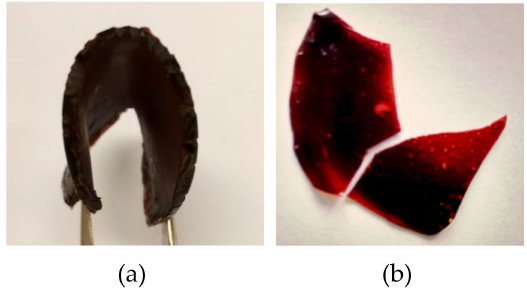
Figure 8. Polymer ( a ) made of monomer {100,24,1,100} was more flexible than polymer ( b ) from monomer {80,24,5,50}, the latter was broken while being